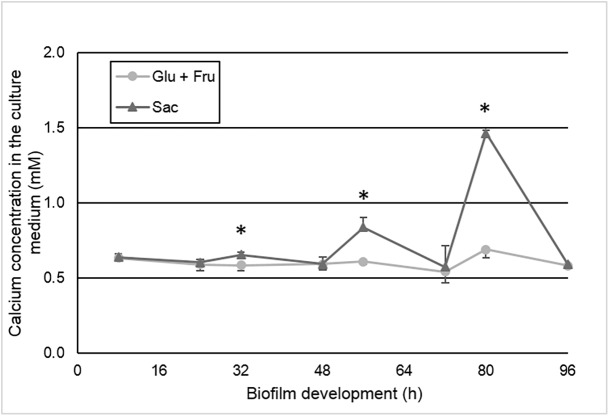
Calcium concentration (mM) in the culture medium according to the biofilm treatments (glucose + fructose or sucrose) and biofilm development time (h).Time points at 80 h and 96 h refer to the harvest moment at abundance and starvation of carbohydrates, respectively. Asterisks indicate statistically significant difference between treatments at the time point evaluated (p < 0.05). (Mean ± SD, n = 12).